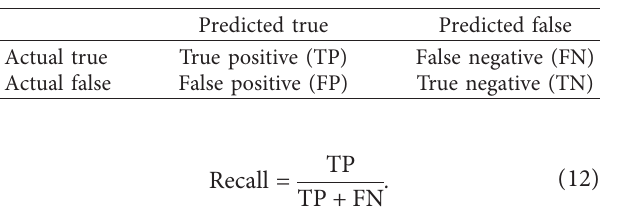
Table 1: Confusion matrix. Table 2: Overall accuracy score for each